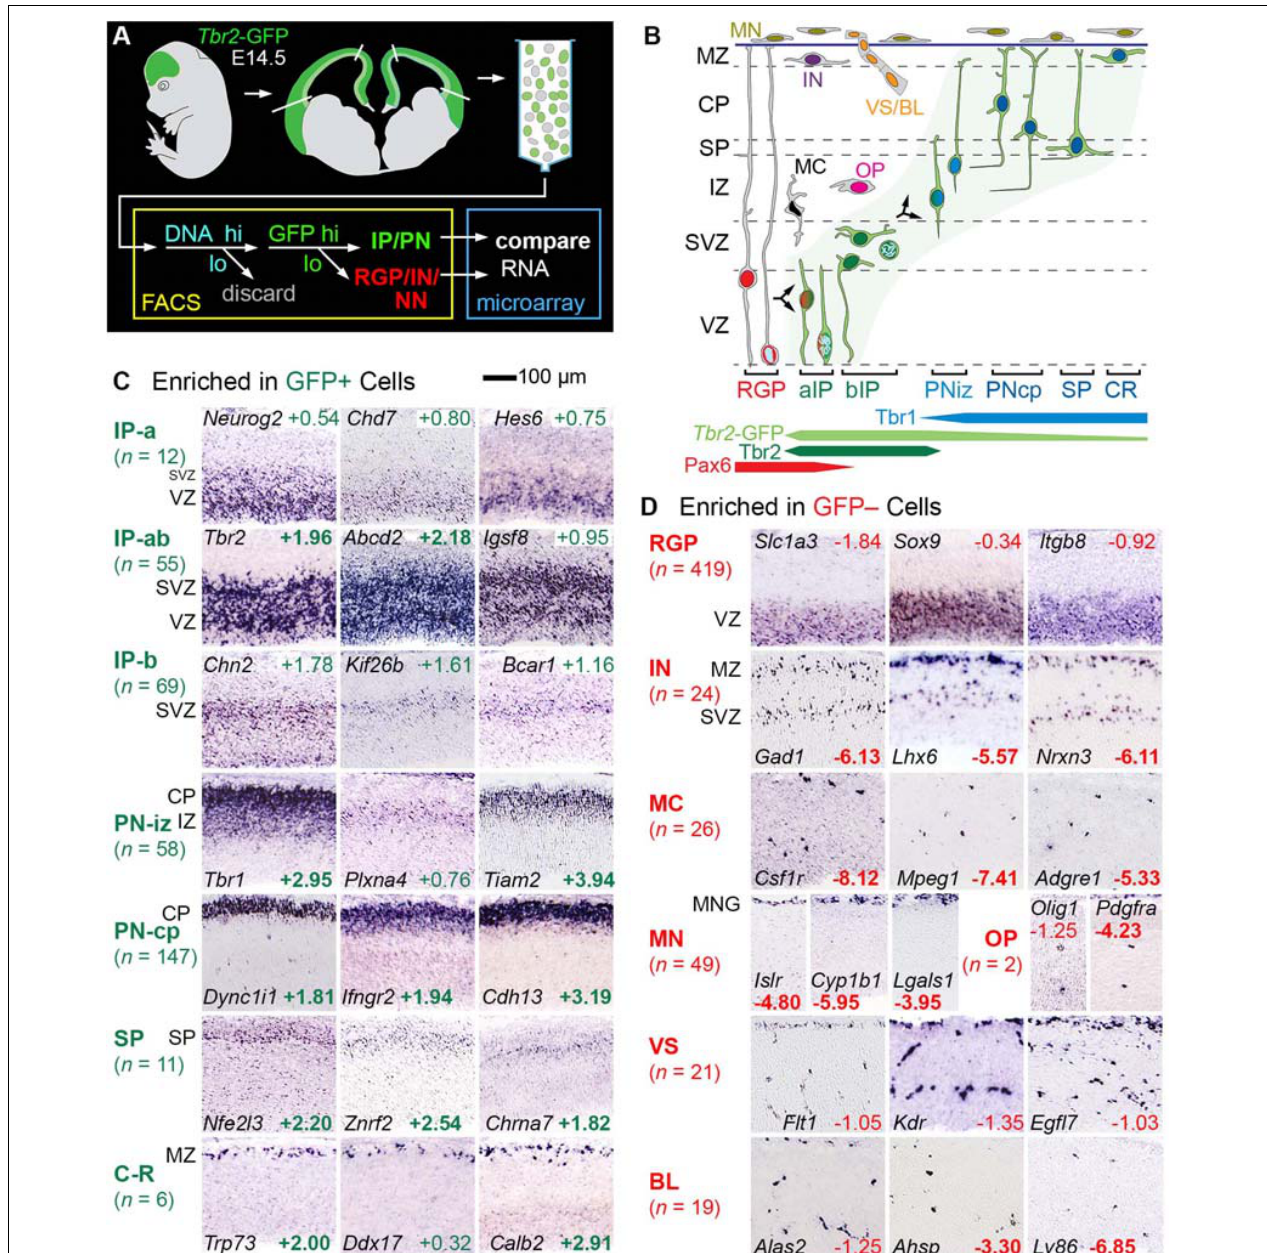
FIGURE 1 | Determination of cell type-selective gene expression in E14.5 mouse neocortex. (A) Cells from E14.5 Tbr2 -GFP neocortex were sorted into GFP+ and GFP– cells, each profiled with transcriptome microarrays. Genes enriched in either group were studied by ISH. Note that sorting by DNA content evidently did not exclude postmitotic cells (see test for details). (B) Schematic of cell types and TF expression in E14.5 neocortex. (C) GFP+ cell types included IPs and PNs in various stages of differentiation, as indicated by typical ISH patterns. Some IP genes were expressed in the VZ and SVZ, indicating apical and basal IPs (IP-ab); others selectively in VZ or SVZ, indicating enrichment in aIP or bIP cells, respectively. (D) GFP– cell types showed characteristic ISH patterns. Numbers are log 2 FC values, in colored text if significant ( p < 0.05), and bold if in the top 300 positively or negatively enriched genes. ISH: Genepaint. Abbreviations: see